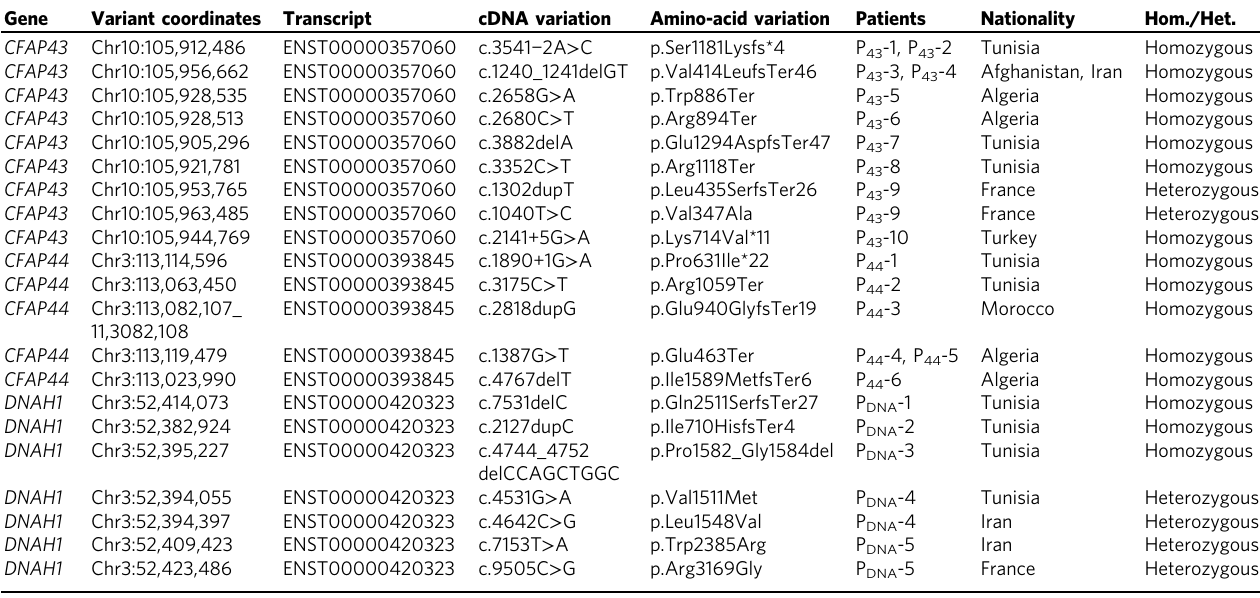
cDNA, complementary DNA; CFAP cilia and fl agella associated protein; WES, whole-exome